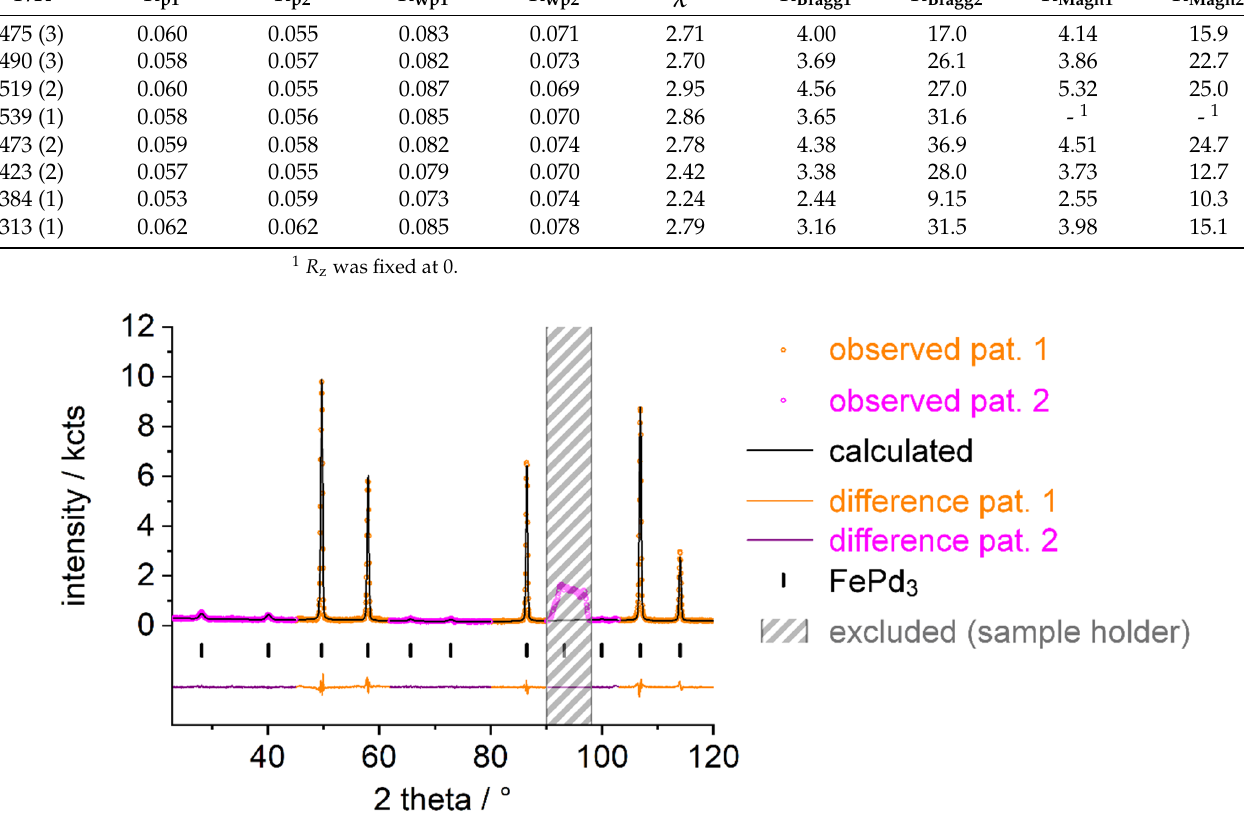
Figure A14. Rietveld refinement of the crystal structure of FePd 3 D 0.046(9) (for details, see second row in Tables A8 and A9) based on neutron powder diffraction data (NUMOR 131755 [21], λ = 186.80(2) pm, D20 ILL, Grenoble) in a single-crystal sapphire cell at 325(3) K and 8.03(1) MPa deuterium pressure using FullProf [24].